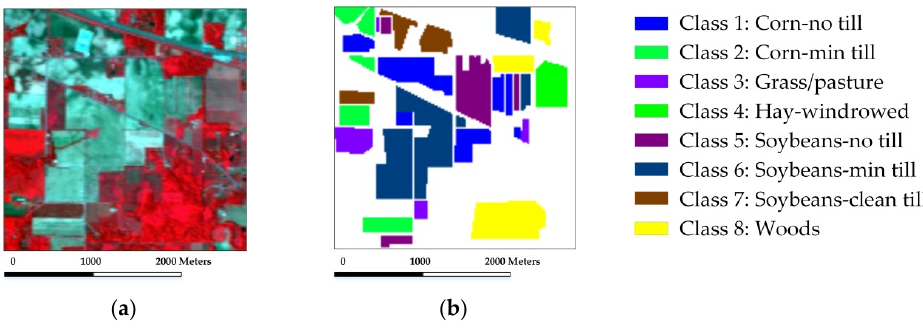
Figure 3. The AVIRIS Indian Pines scene: ( a ) false-color composite image; ( b ) reference map.